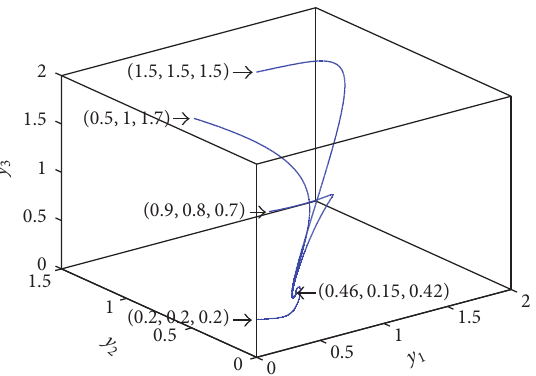
Figure 1: 3D phase plot of the system (3) for the data given by (69) starting from different initial values in which the solution approaches asymptotically to 0.46, 0.15, and 0.42.